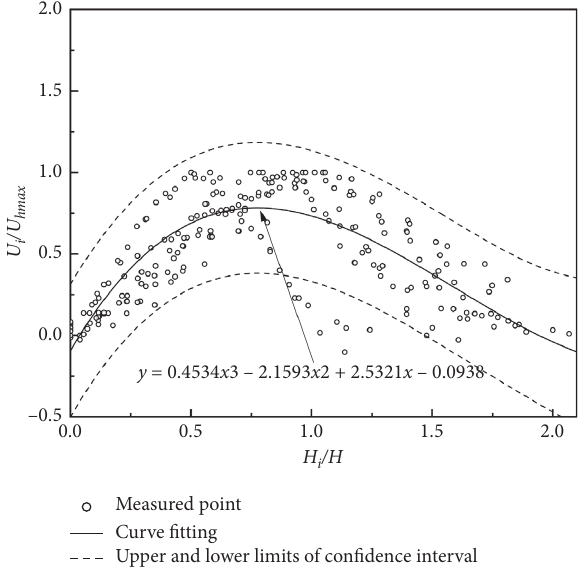
Figure 10: Dimensionless treatment of the lateral deformation mode of the wall.